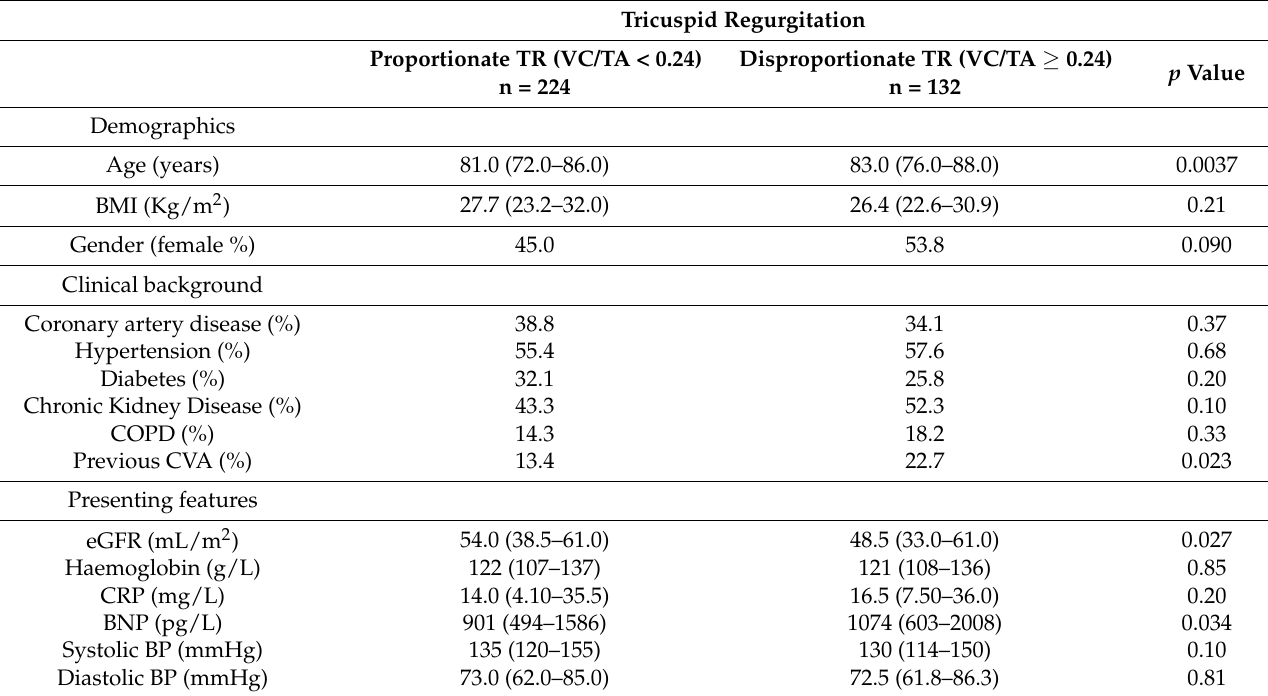
Table 1. Baseline demographics, clinical history, presenting features and outcome of patients delin- eated by threshold for disproportionate TR. Tricuspid